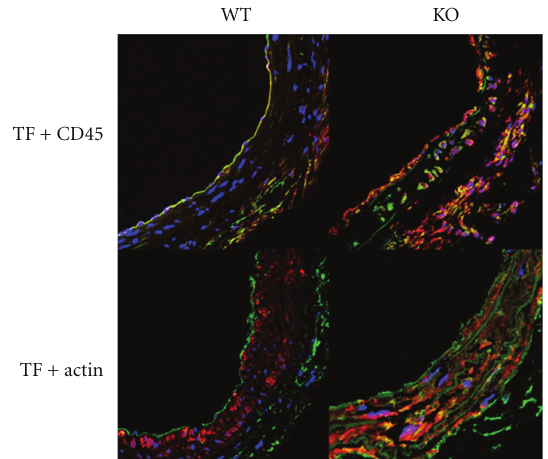
Figure 5: Double immunofluorescent staining for identifying the cell source of TF. Optical sectioning was averaged over four frames and the image size was set at 1024 × 1024 pixels. There were no digital adjustments made to the images. TF with CD45: TF (Green), CD45 (Red) & DAPI (Blue). TF with SMC α -actin: TF (Green), α -actin (Red) & DAPI (Blue). Our data indicated that more TF- positive cells were found in the PPAR α − / − mice, which is overlapped with the CD45-posttive cells, suggesting CD45-positive cells as the source of